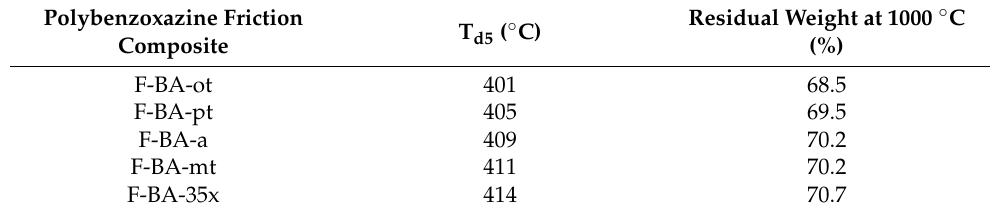
Table 3. Thermal stability obtained from the TGA of polybenzoxazine